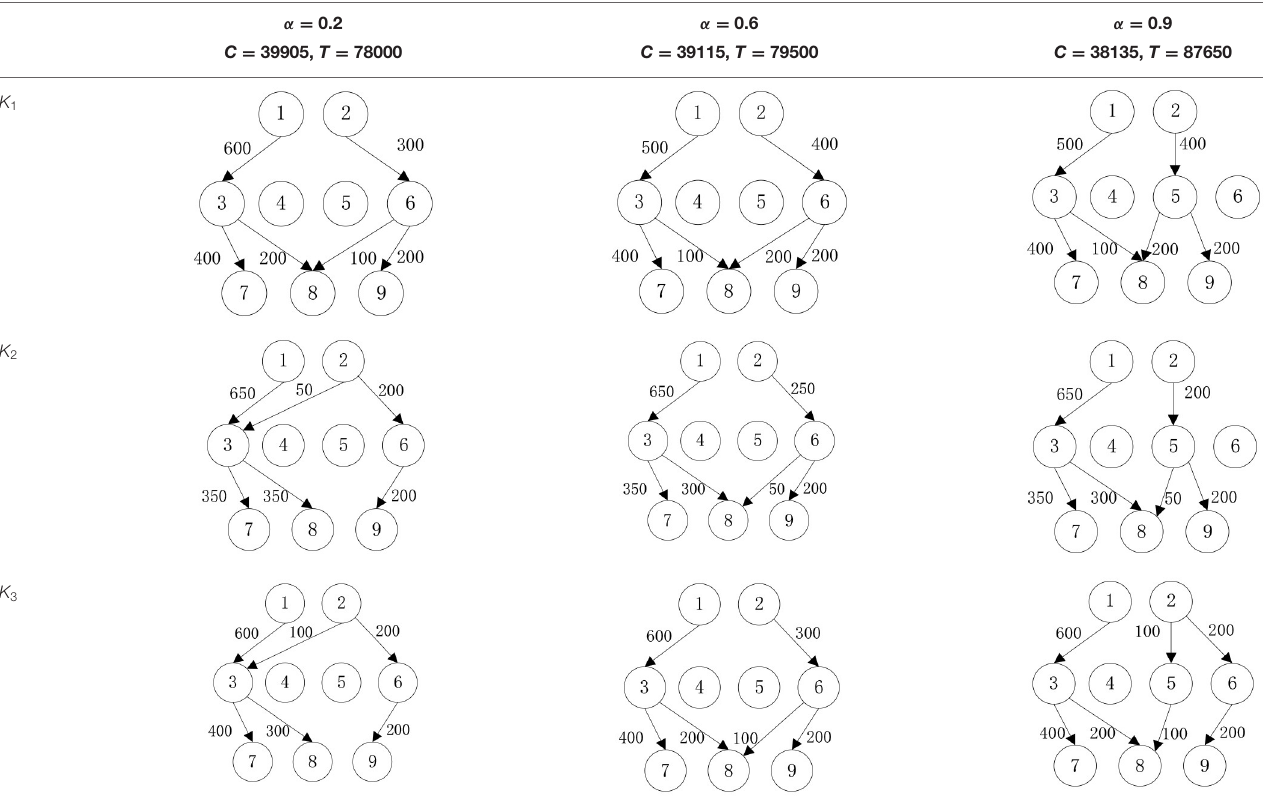
TABLE 6 | Optimal allocation routes and quantities of mobile emergency materials under three cost